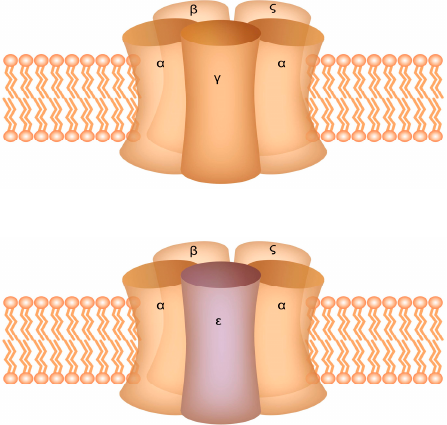
Figure 1. Schematic representation of the Acetylcholine receptor structure—there are structural dif- ferences between the fetal-type ( up ) and the adult-type ( down ). differences between the fetal-type ( up ) and the adult-type ( down